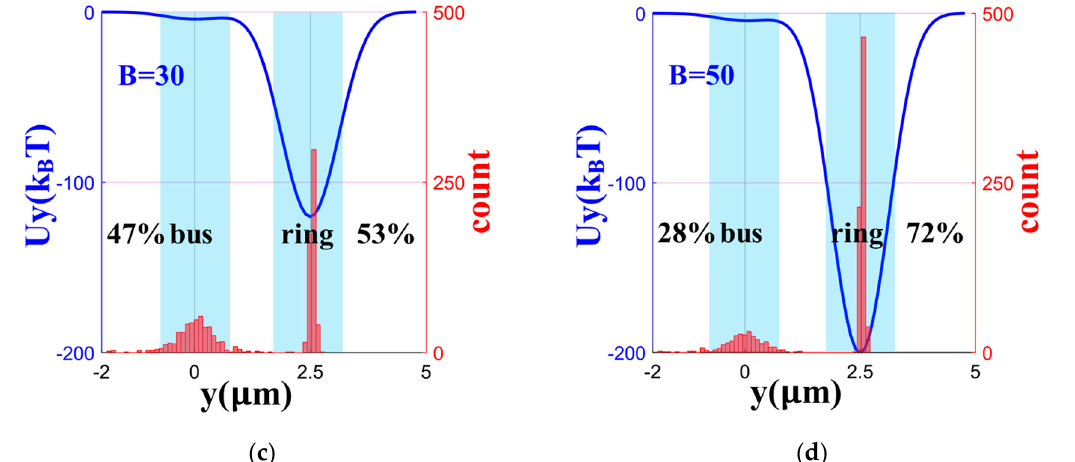
Figure 4. ( a ) Potential wells of 3 µ m diameter spheres in the y-direction with B = 1, 2, and 3. ( b ) The particle distribution on the ring and bus in 5 s when B = 10. The particle distribution on the ring and bus in 5 s when ( c ) B = 30 and ( d ) B = 50.